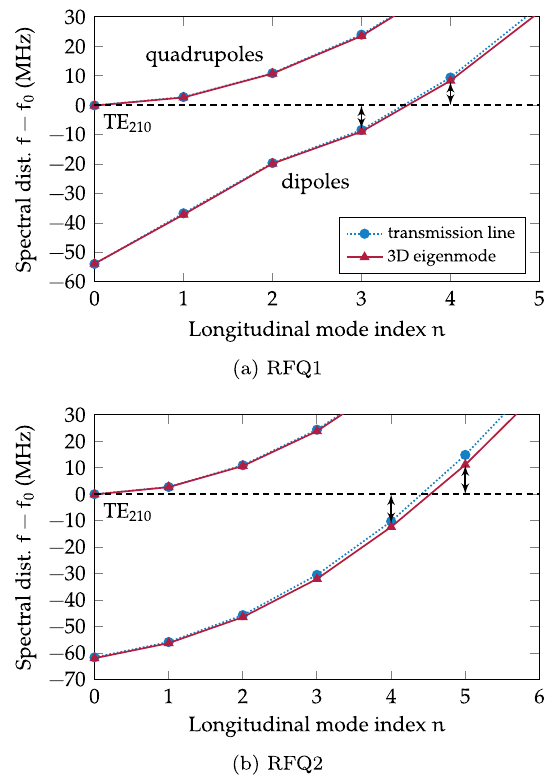
FIG. 19. Eigenmode spectra of the two cavities RFQ1 (a) and RFQ2 (b) after dipole detuning using the RFQ length. The margins between TE 210 and the closest dipole modes read (cid:3) 8 MHz and (cid:3) 11 MHz,